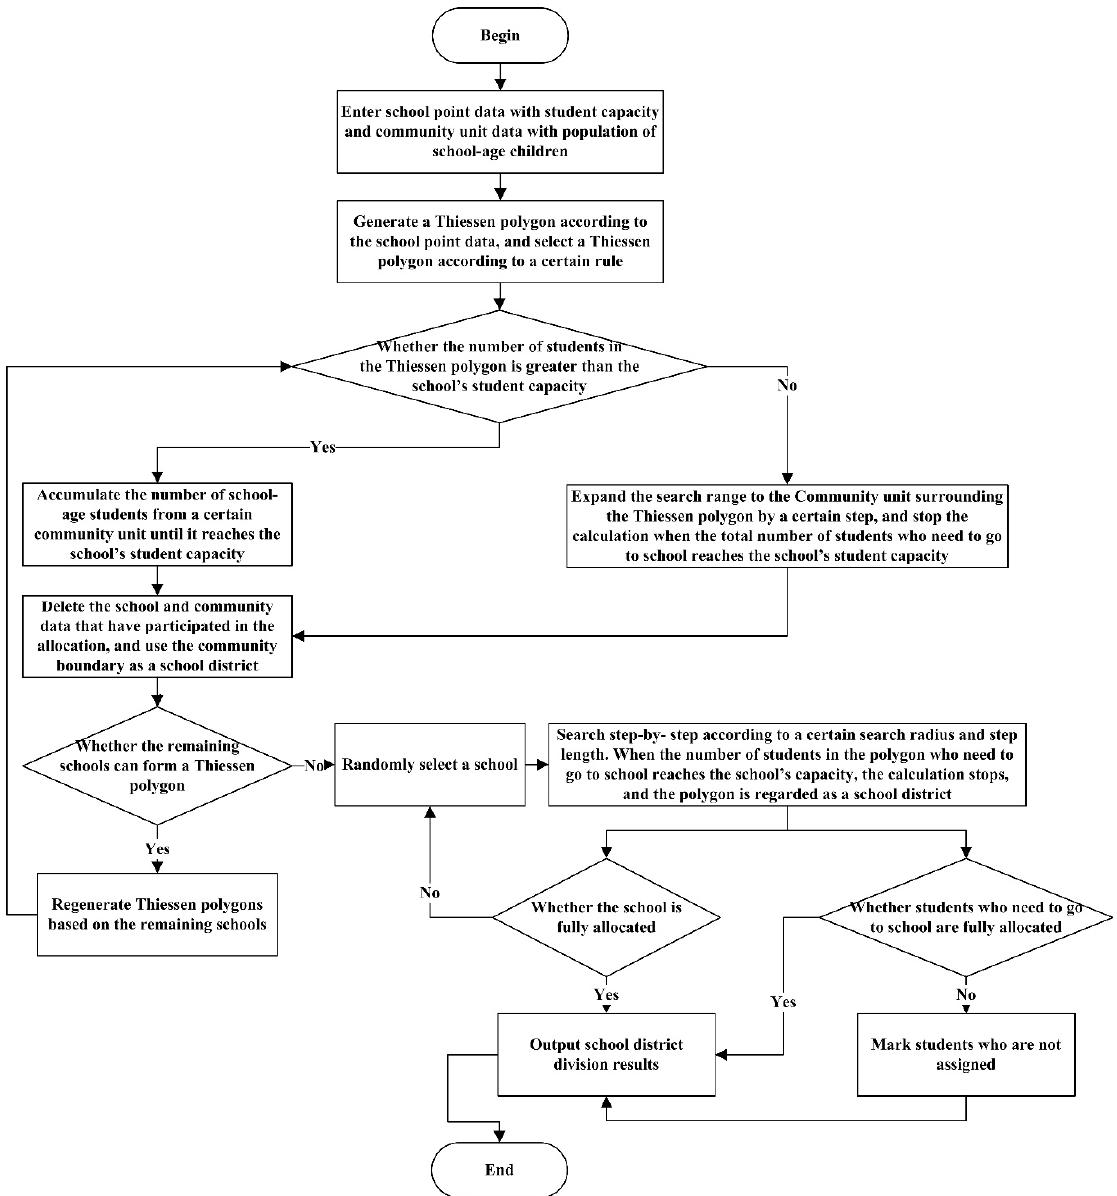
Figure 1. Flow chart of the CCDV method.